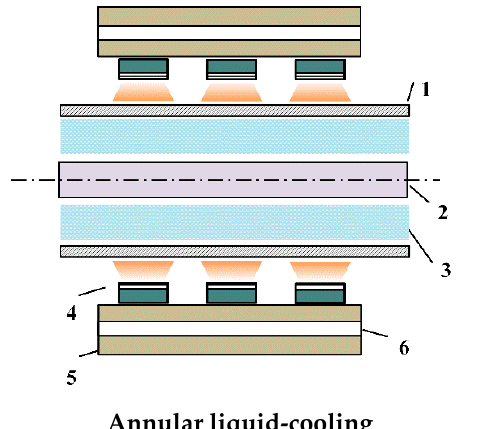
Figure 1. Segmented circular laser diode (LD) array side-pumping configuration.